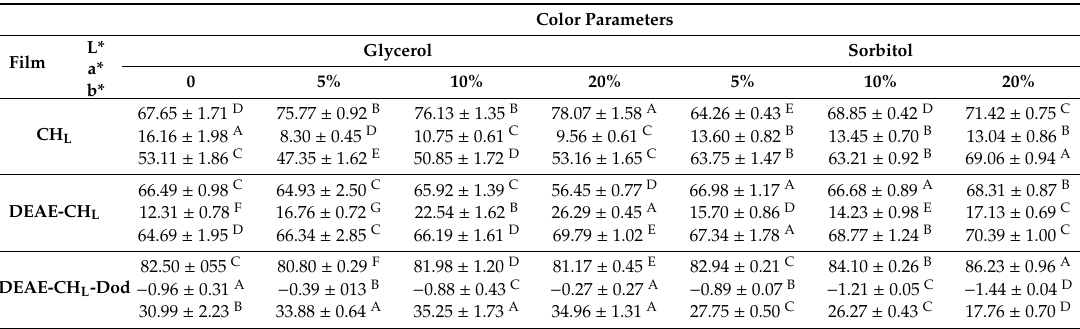
Table 5. Color properties of films of chitosan and its